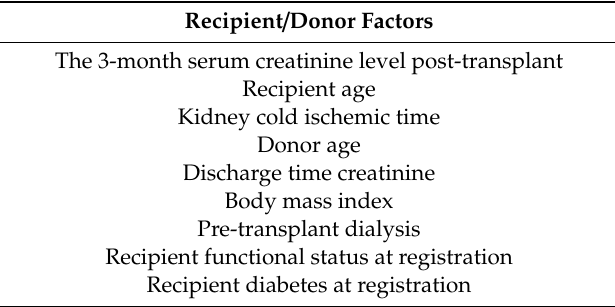
Table 4. Main factors influencing